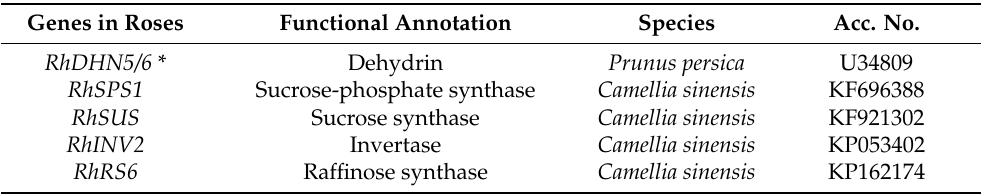
Table 1. List of candidate genes in other species used to identify the putative homologue and isolate from the Rosa spp. transcriptome database.